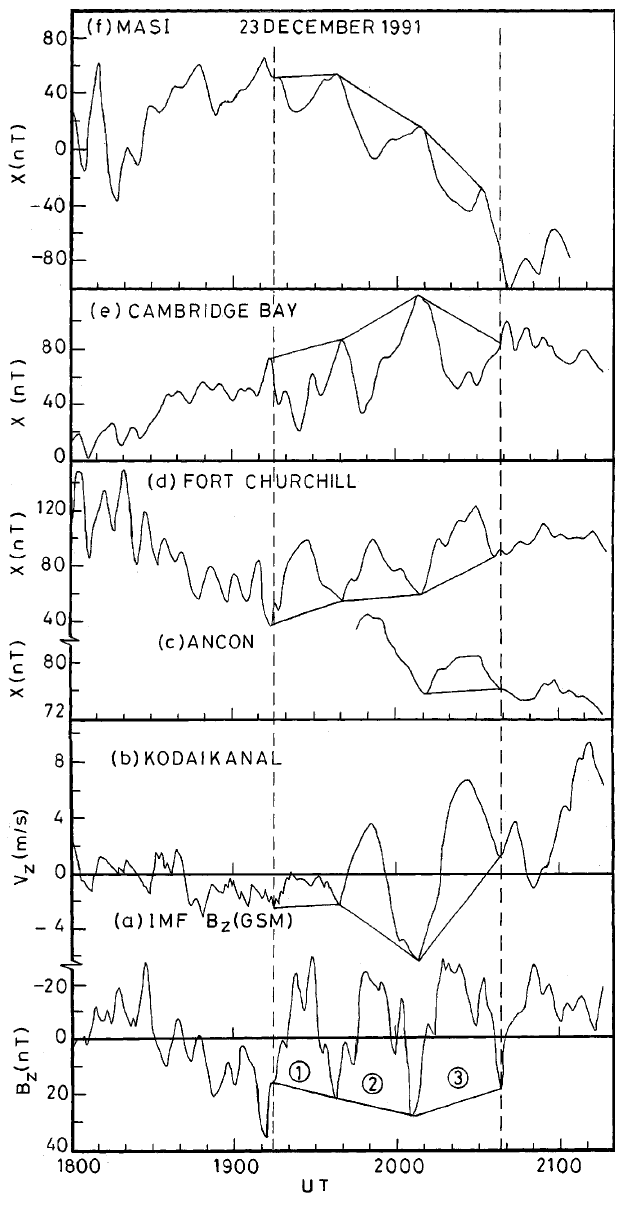
Fig. 2a–f. Variation during 1800–2120 UT on 23 December 1991 of a IMF B , b F region vertical plasma drift at Kodaikanal in the z midnight sector, c–e geomagnetic H / X component at Ancon, Fort Churchill and Cambridge Bay on the dayside and f at the IMAGE station, Masi in the dusk sector. Note that a time shift of 17 min is introduced for IMF B to show the temporal coherence of quasi- z periodic fluctuations (labelled 1–3 ) in the parameters at the various locations over the time interval 1915–2038 UT marked by vertical dashed